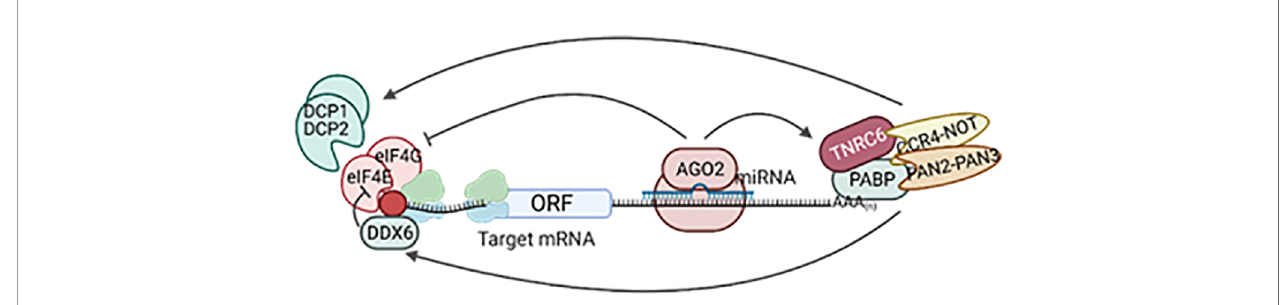
FIGURE 3 | MiRNA mechanism of gene silencing. Following loading into miRISC, the miRNA guides the complex to partially complementary target mRNAs. MiRISC recruits TNRC6, PABPC, and deadenylase complexes CCR4-NOT and PAN2-PAN3, shortening the poly(A) tail. This can be followed by decapping and 5 ’ -to-3 ’ exonucleolytic degradation and/or recruitment of the helicase DDX6 to inhibit translation. Other mechanisms of translational repression include inhibition of the recruitment of initiation factors (eIF4) and ribosome scanning. Created